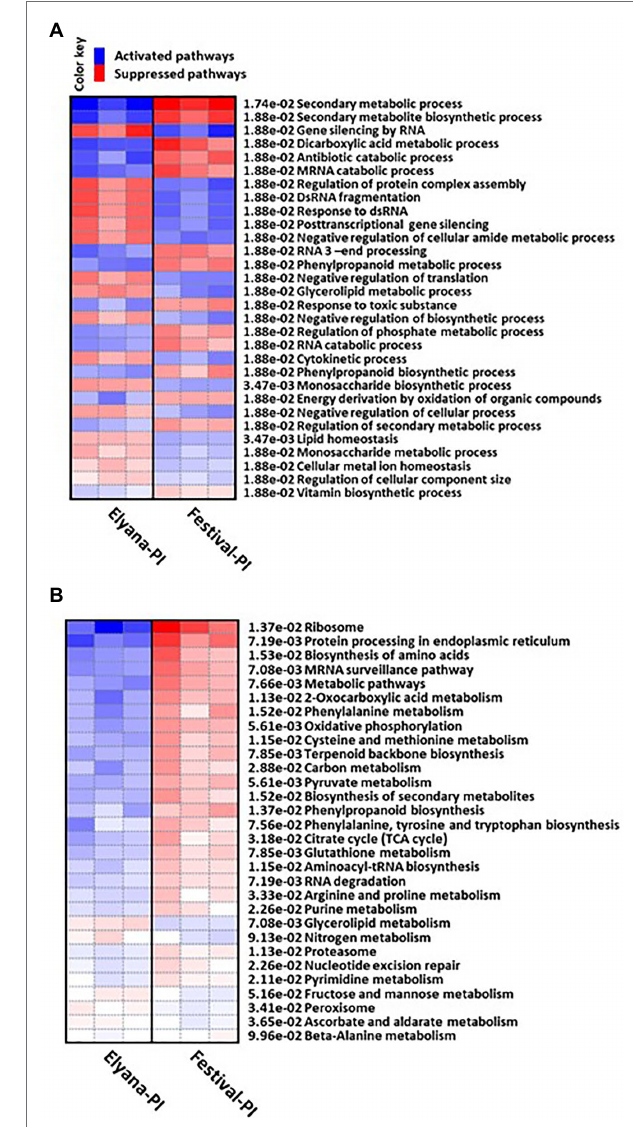
FIGURE 3 | Heatmap representation of the differentially expressed genes enriched gene ontology (GO) process under the category of (A) Biological Process (BP) and (B) KEGG pathways. ( Figure 7C ; Table 1 ; Supplementary Tables S3 and S4 ). Among